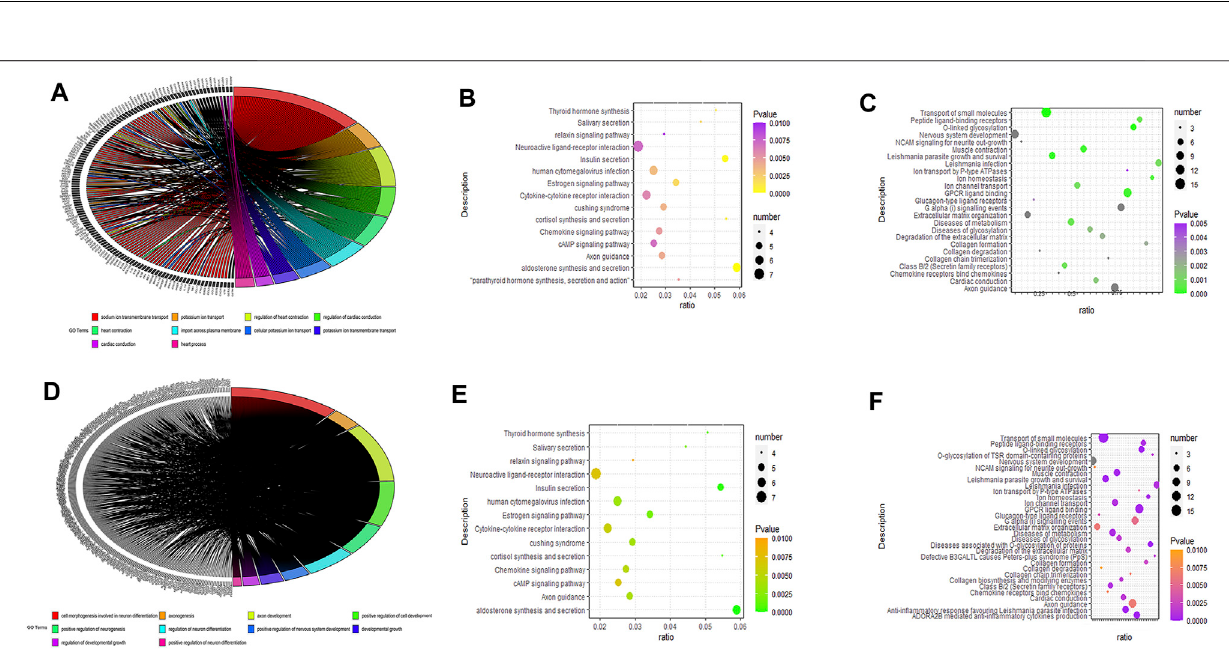
Frontiers in Genetics |